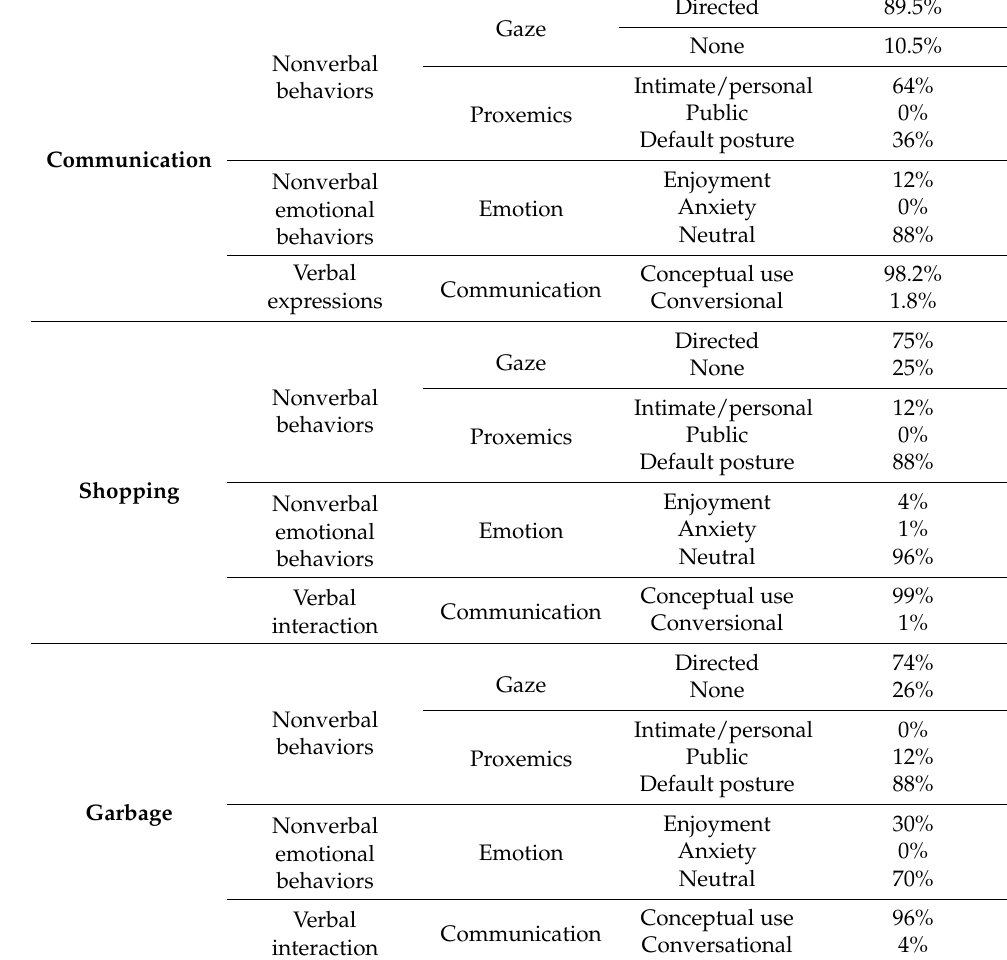
Table 2. Mean percentages of time for each coded